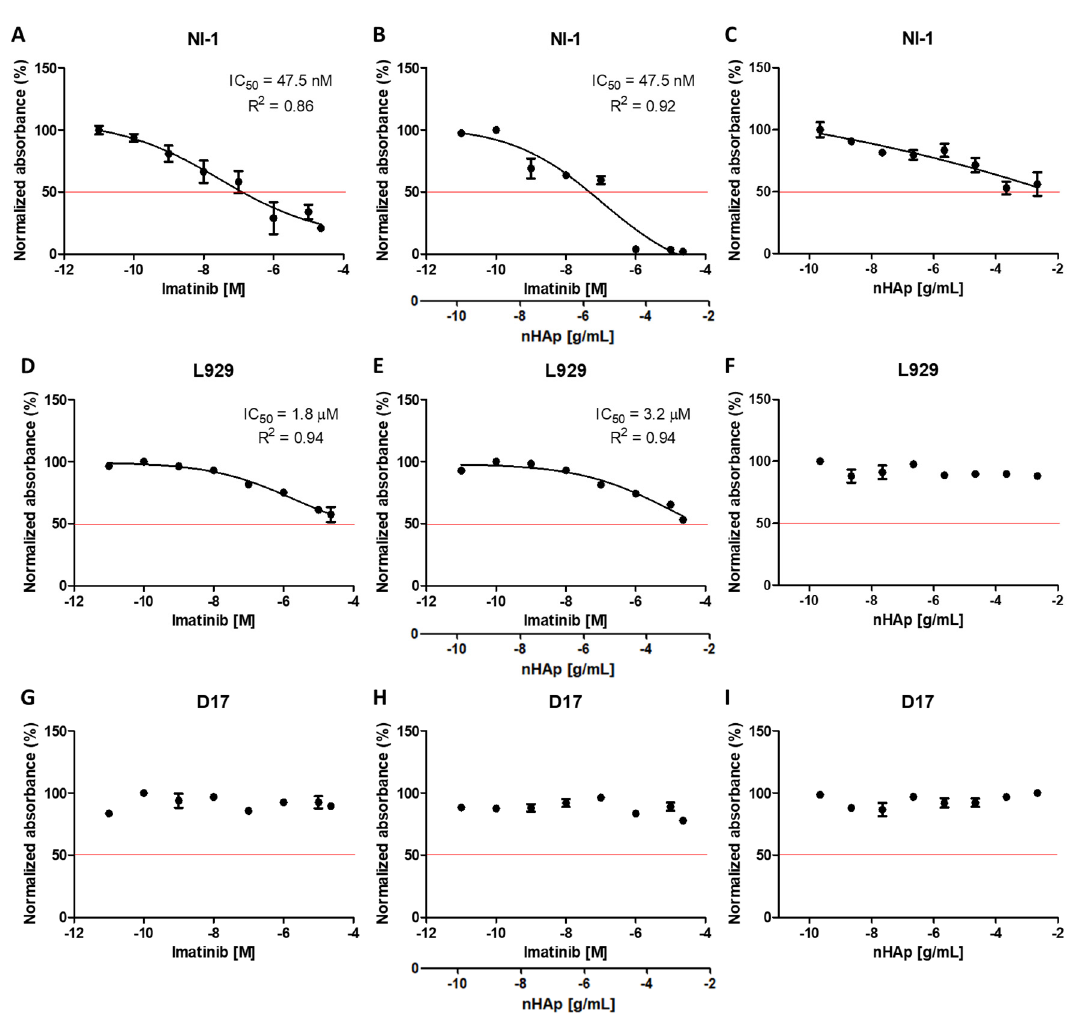
Figure 5. TOX-8 viability test results for NI-1 ( A – C ), L929 ( D – F ), and D17 ( G – I ) cells depending on the concentration of experimental compounds used: imatinib, nHAp modified with imatinib and nHAp alone. IC 50 is indicated if possible. R 2 stands for the coefficient of determination.